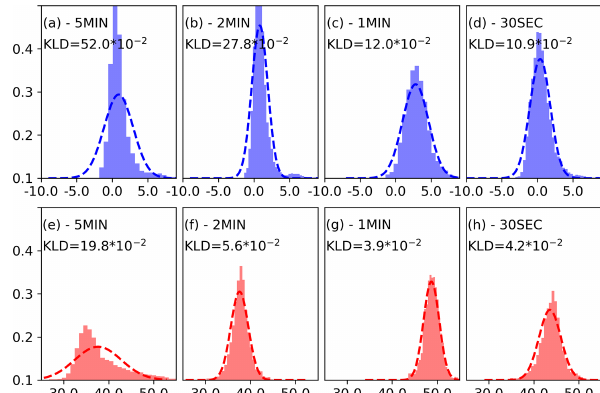
Figure 3. Sample histograms for (a–d) vertical velocity (ms − 1 – meters per second) and (e–h) reflectivity (dBZ) at the location of the maximum KLD for vertical velocity (black cross in Fig. 2). Thick dashed curves indicate fitted Gaussian functions, and KLD non- Gaussian measures are also indicated. Each column corresponds to 5MIN, 2MIN, 1MIN, and 30SEC from left to right, respectively.